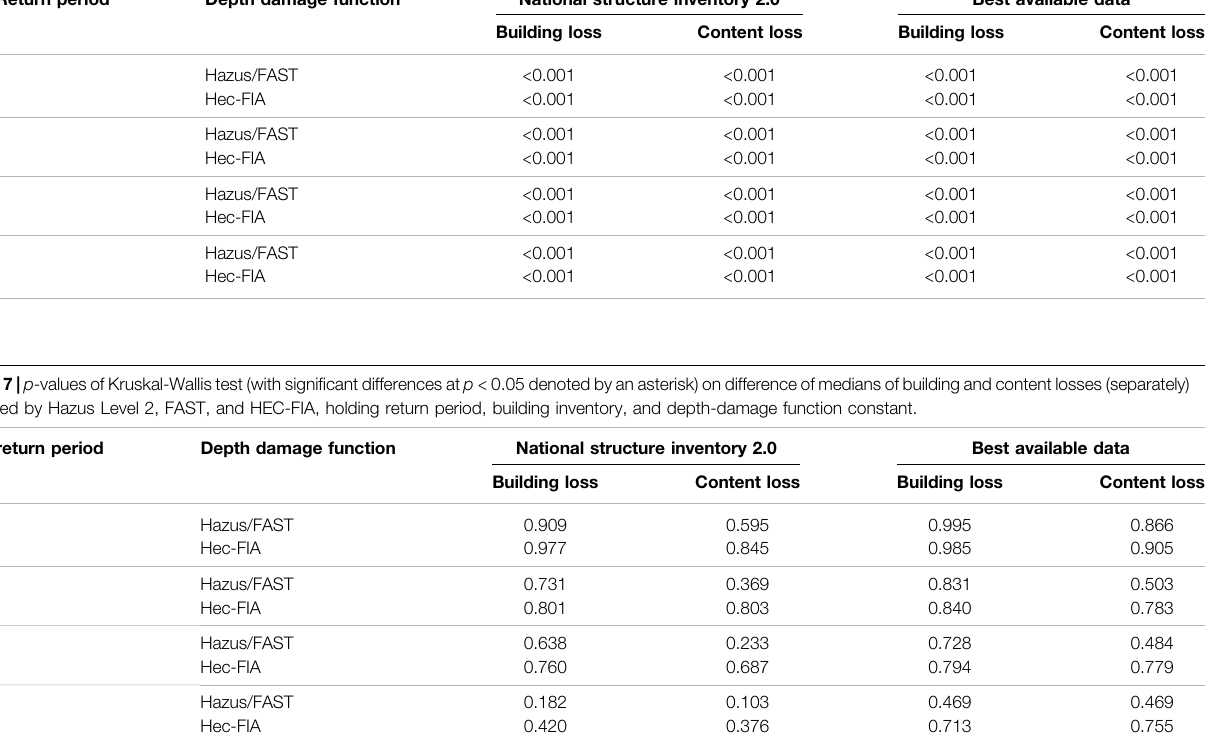
TABLE 6 | p -valuesofShapiro-Wilknormality test (with values < 0.05 representinganon-normaldistribution) ofmodel sensitivity among Hazus Level2, FAST, and HEC-FIA. Flood Return period